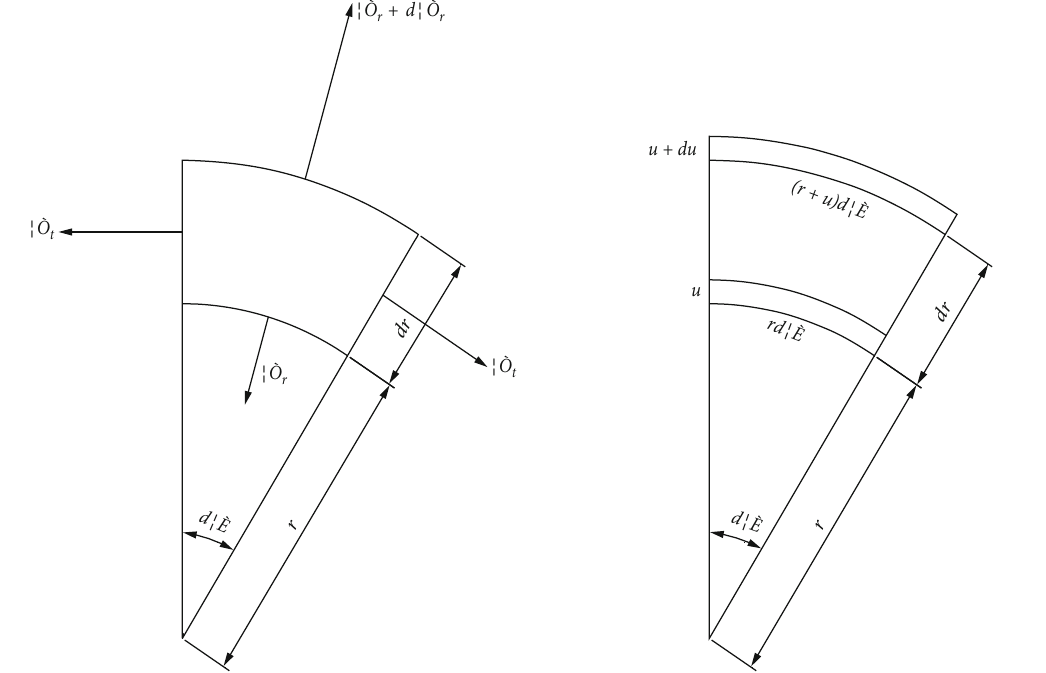
Figure 1: Schematic diagram of force and deformation of surrounding rock unit.